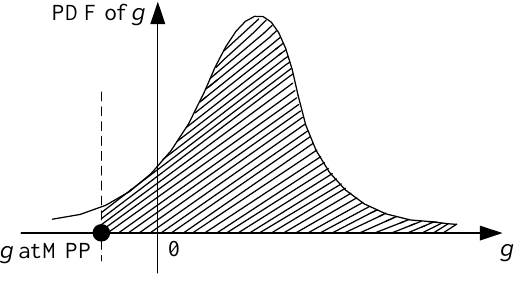
Figure 1. Probability density function of g [37].